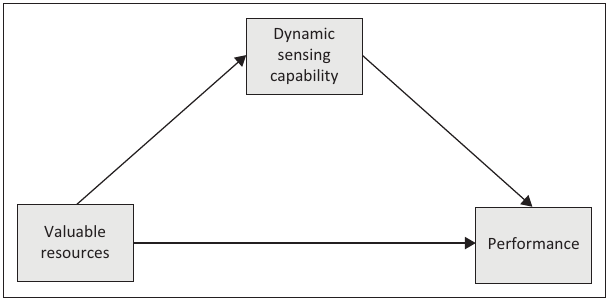
FIGURE 1: Conceptual model to test valuable resources-dynamic sensing capability-performance